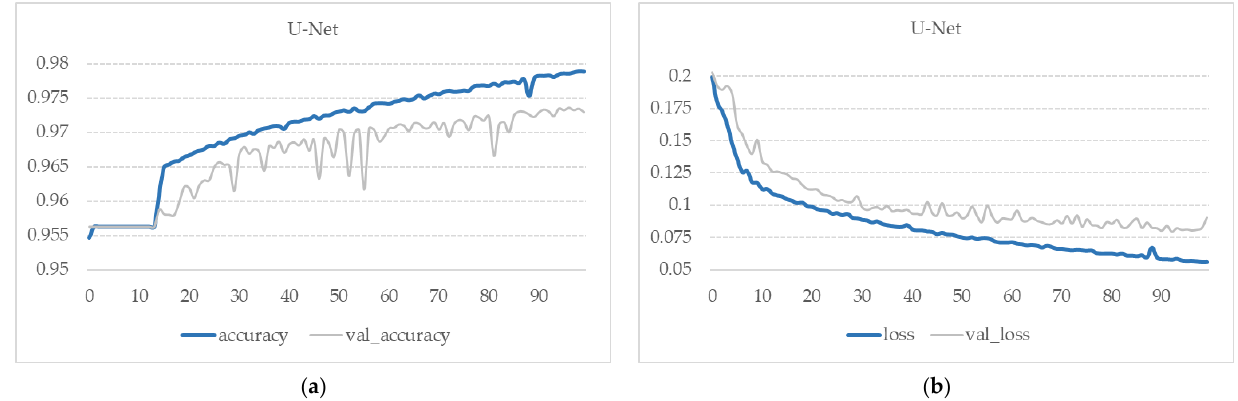
Figure 5. Model performance: ( a ) accuracy and ( b ) loss for our fine-tuned U-Net.